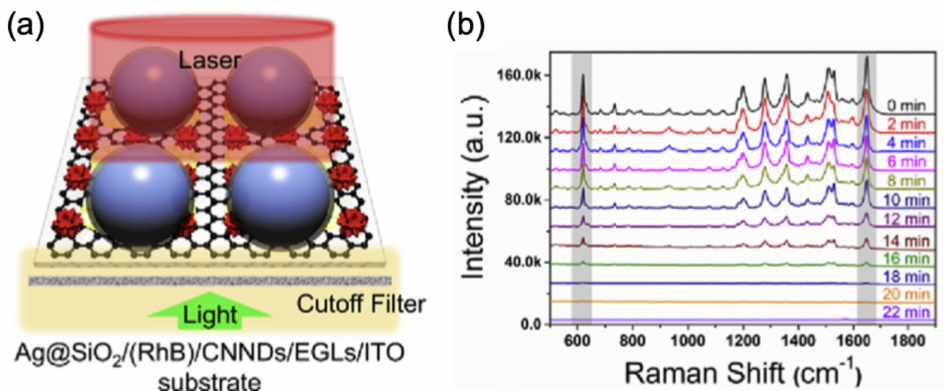
Figure 6. ( a ) Principle scheme for the photocatalytic process of degradation of RhB molecules (RhB = red shapes) probed by SHINERS (Ag@SiO 2 NPs = blue spheres with a grey shell). The yellow shapes correspond to the g-C 3 N 4 nanodots (CNNDs), and the EGLs/ITO substrate is represented by the white rectangle on which the hexagonal lattice of graphene (EGLs) is depicted. ( b ) SHINERS spectra of RhB molecules recorded for various illumination times in the range 0–22 min. All the figures are reprinted from [100], Copyright 2019, with permission from Elsevier.